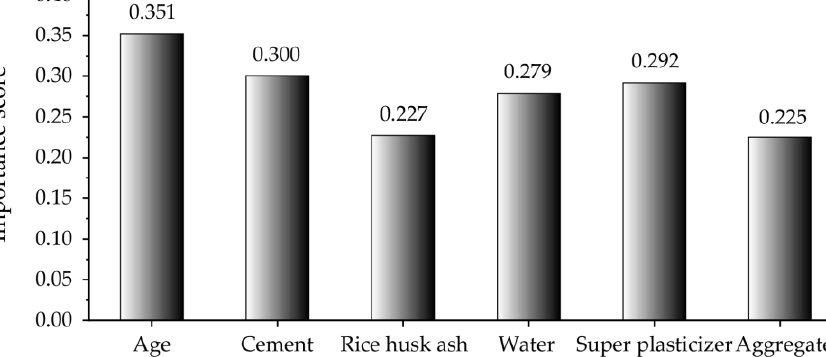
Figure 11. Importance score of each parameter based on the CMRSA-ANN model.